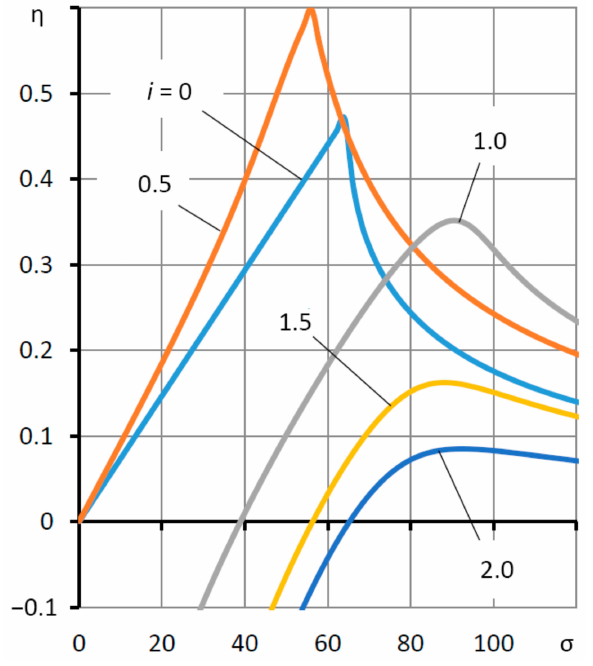
Figure 7. Dependences of the degree of stability η on the “compression number” σ for different values of the coefficient of elasticity K e = i K e 0